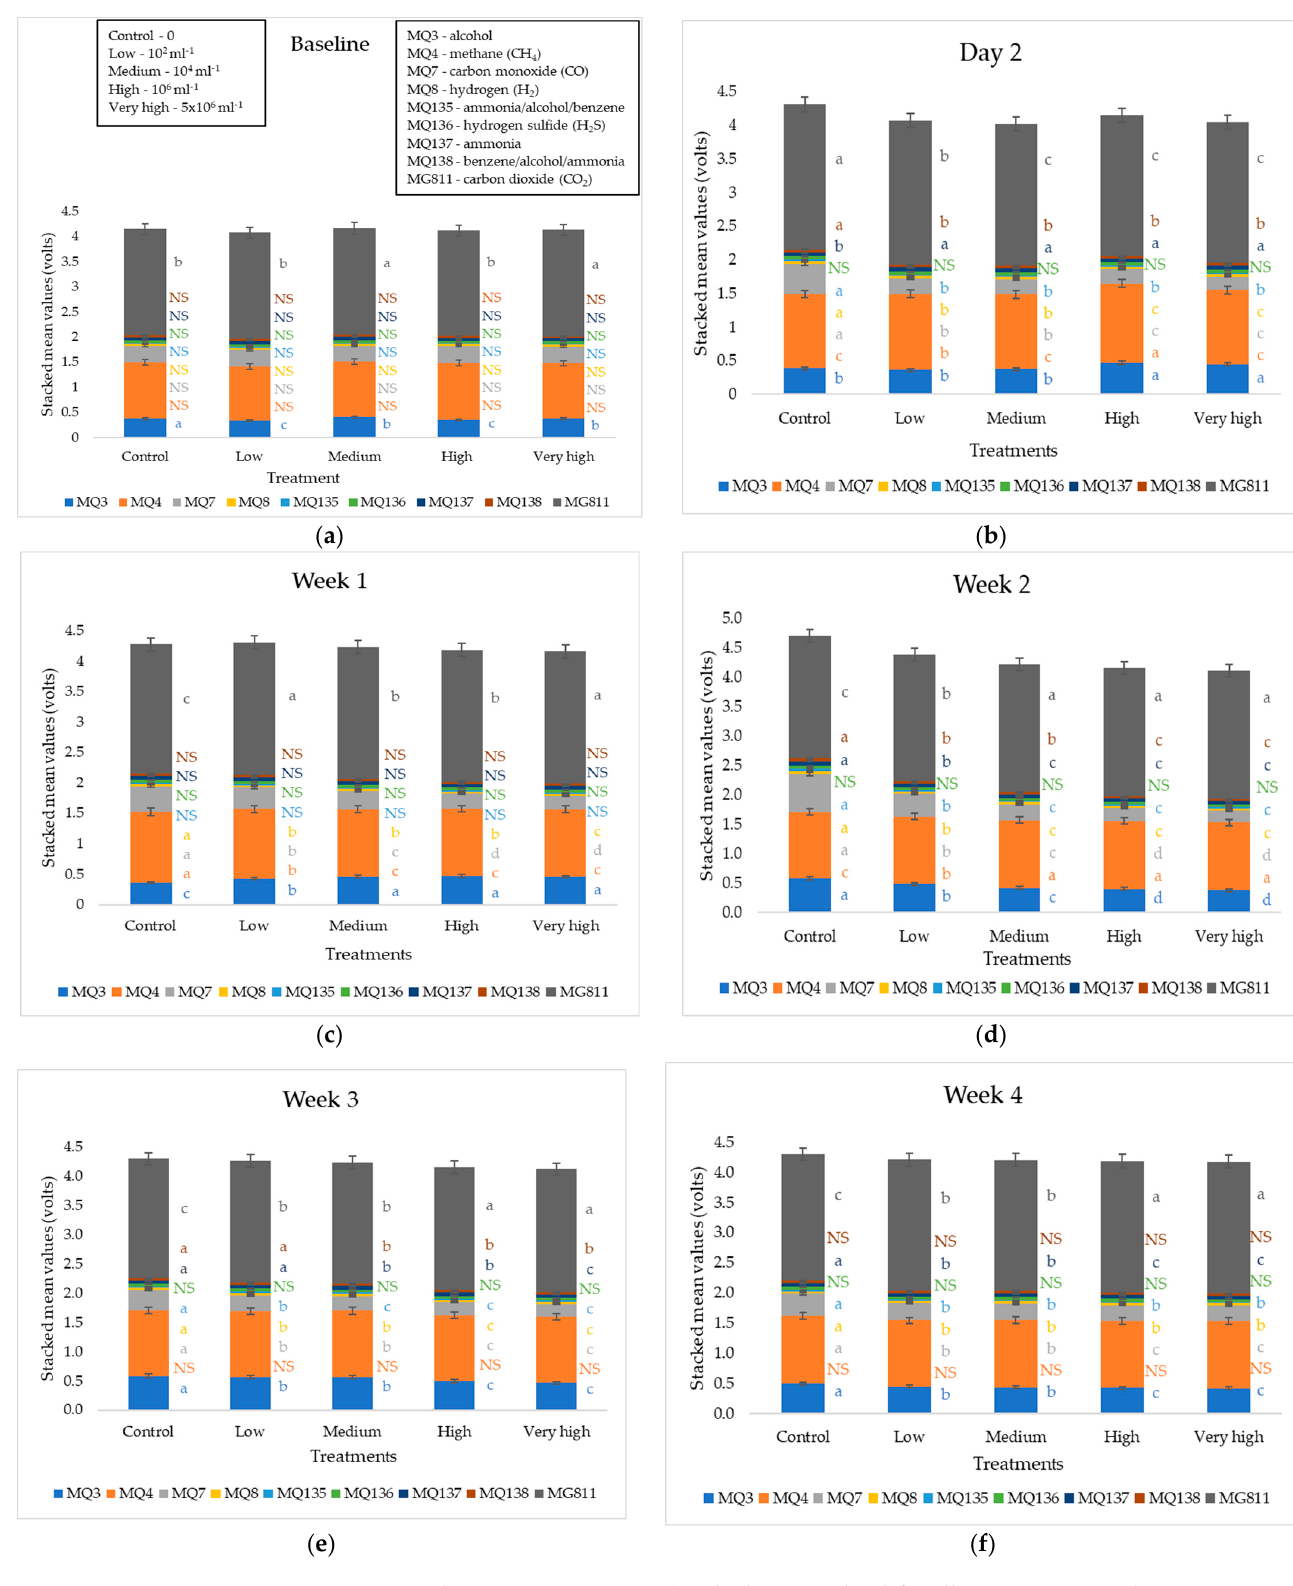
Figure 4. Electronic nose outputs (stacked mean values) for all treatments at each measurement of the parallel soil experiment ( a ) baseline, ( b ) day 2, ( c ) week 1, ( d ) week 2, ( e ) week 3, and ( f ) week 4. Error bars represent 95% confidence intervals, and columns that do not share the same letters are significantly different ( p < 0.05).